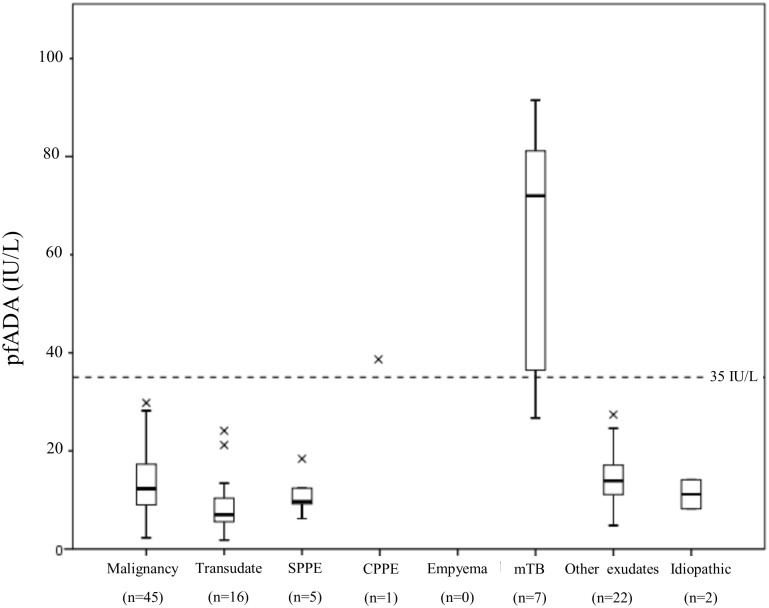
Boxplot of pfADA levels by diagnostic category for lymphocyte predominant effusions (n = 98).Abbreviations; SPPE—Simple parapneumonic effusion, CPPE—Complicated parapneumonic effusion, mTB—mycobacterium tuberculosis.